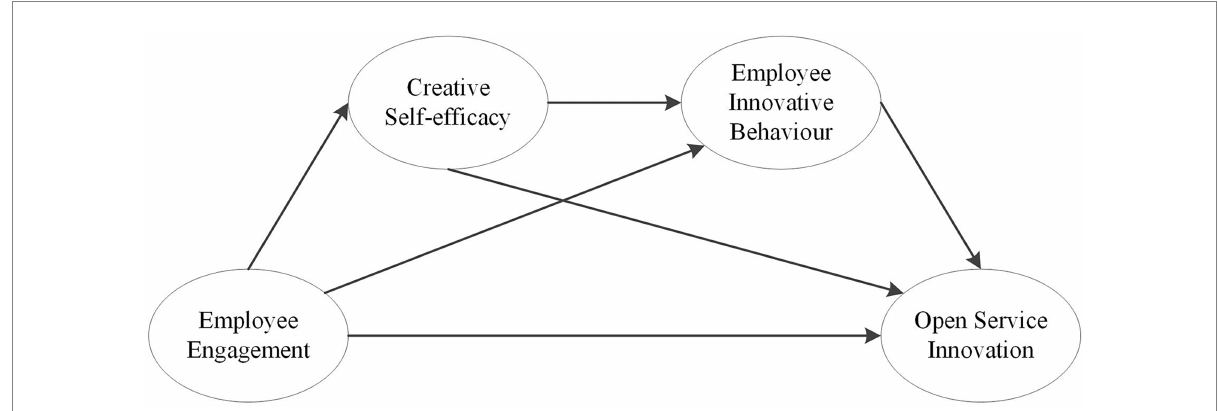
FIGURE 1 Hypothesis model of the employee engagement mechanism on open service